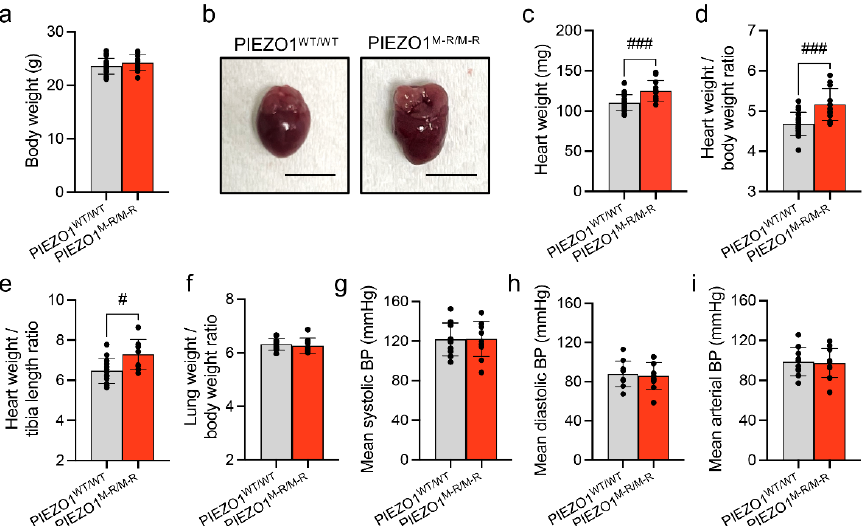
Figure 1. PIEZO1 gain-of-function mutation causes increases heart size without changes in blood pressure. ( a ) Body weight of PIEZO1 WT/WT and PIEZO1 M-R/M-R mice. ( b ) Representative whole heart images of PIEZO1 WT/WT and PIEZO1 M-R/M-R mice. Scale bar = 0.5 cm. ( c – f ) Morphometric analysis of PIEZO1 WT/WT and PIEZO1 M-R/M-R mice. ( c ) Heart weight; ( d ) ratio of heart weight to body weight; ( e ) ratio of heart weight to tibia length; ( f ) ratio of lung weight to body weight. ( g – i ) Blood pressure (BP) parameters. ( g ) Systolic; ( h ) diastolic; ( i ) mean arterial BP of PIEZO1 WT/WT and PIEZO1 M-R/M-R mice. Data are for n = 22 PIEZO1 WT/WT and 12 PIEZO1 M-R/M-R mice for ( a – d ); n = 13 PIEZO1 WT/WT and 8 PIEZO1 M-R/M-R mice for ( e , f ) and n = 10 PIEZO1 WT/WT and 11 PIEZO1 M-R/M-R mice for ( g – i ) (mean ± S.D.). Superimposed dots represent the individual values for each animal. # p < 0.05; ### p < 0.001 vs. PIEZO1 WT/WT mice. Unpaired Student’s t -test was used to evaluate statistical